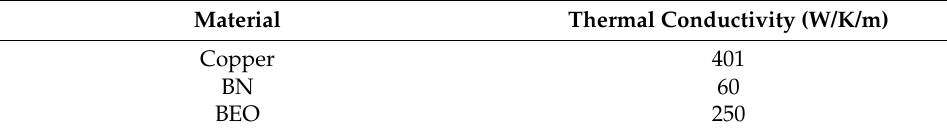
Table 3. Material properties in the